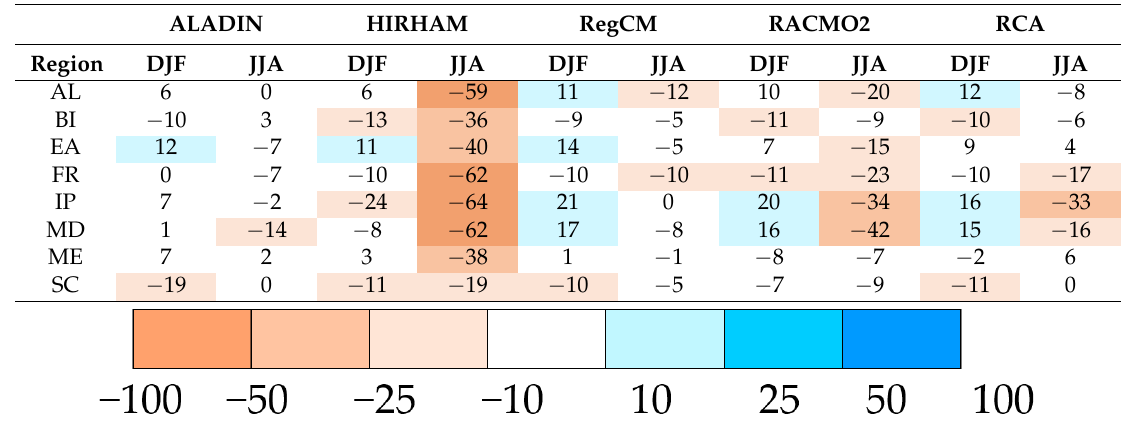
Table 8. Residual bias of seasonal amount of simulated precipitation in the case of gpQM bias correction in the test period in eight different regions: the Alps (AL), the British Isles (BI), Eastern Europe (EA), France (FR), the Iberian Peninsula (IP), the Mediterranean (MD), Mid-Europe (ME) and Scandinavia (SC) in DJF and JJA. The bias values are in